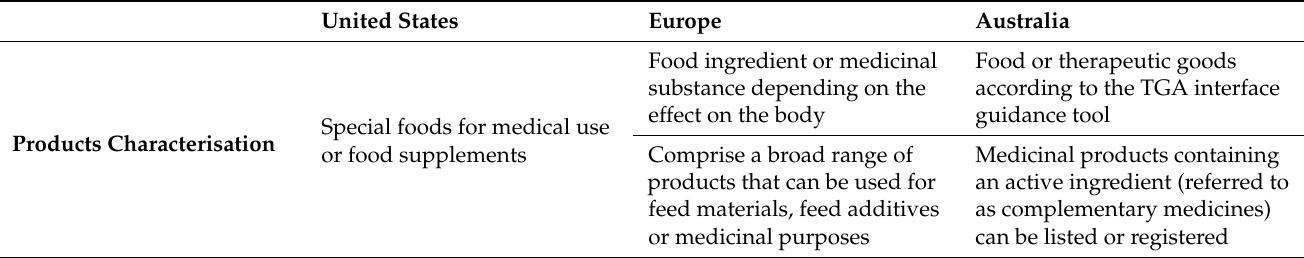
Table 1. The definition of nutraceuticals and their regulation varies between different